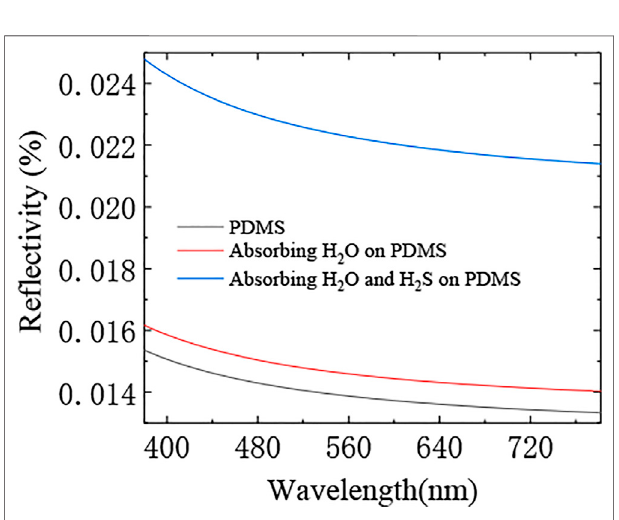
FIGURE 8 | Simulated re fl ectivity of silicone (PDMS) with adsorption of different molecules.